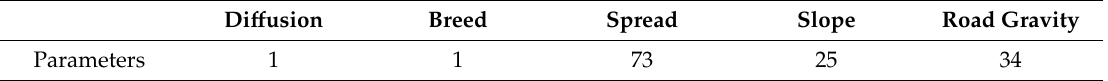
Table 2. Final calibration parameters for Monastir.